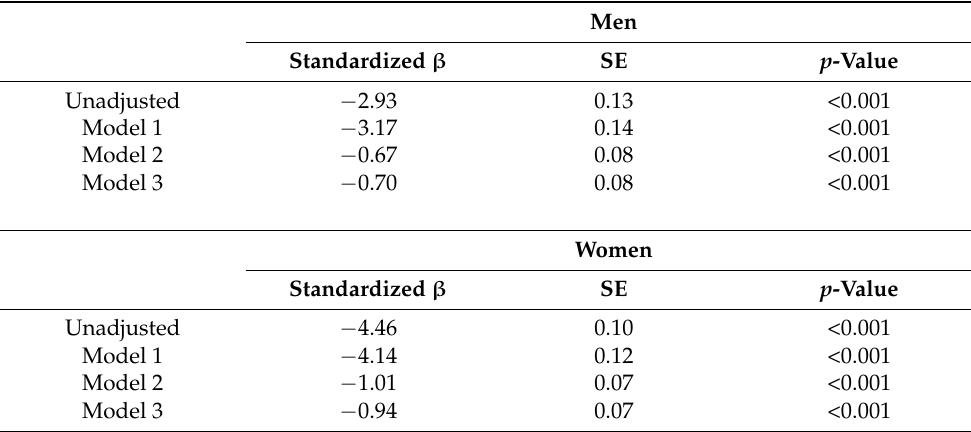
Table 2. Results of multiple linear regression analysis to assess the independent relationships between RGS and HSI in Koreans.